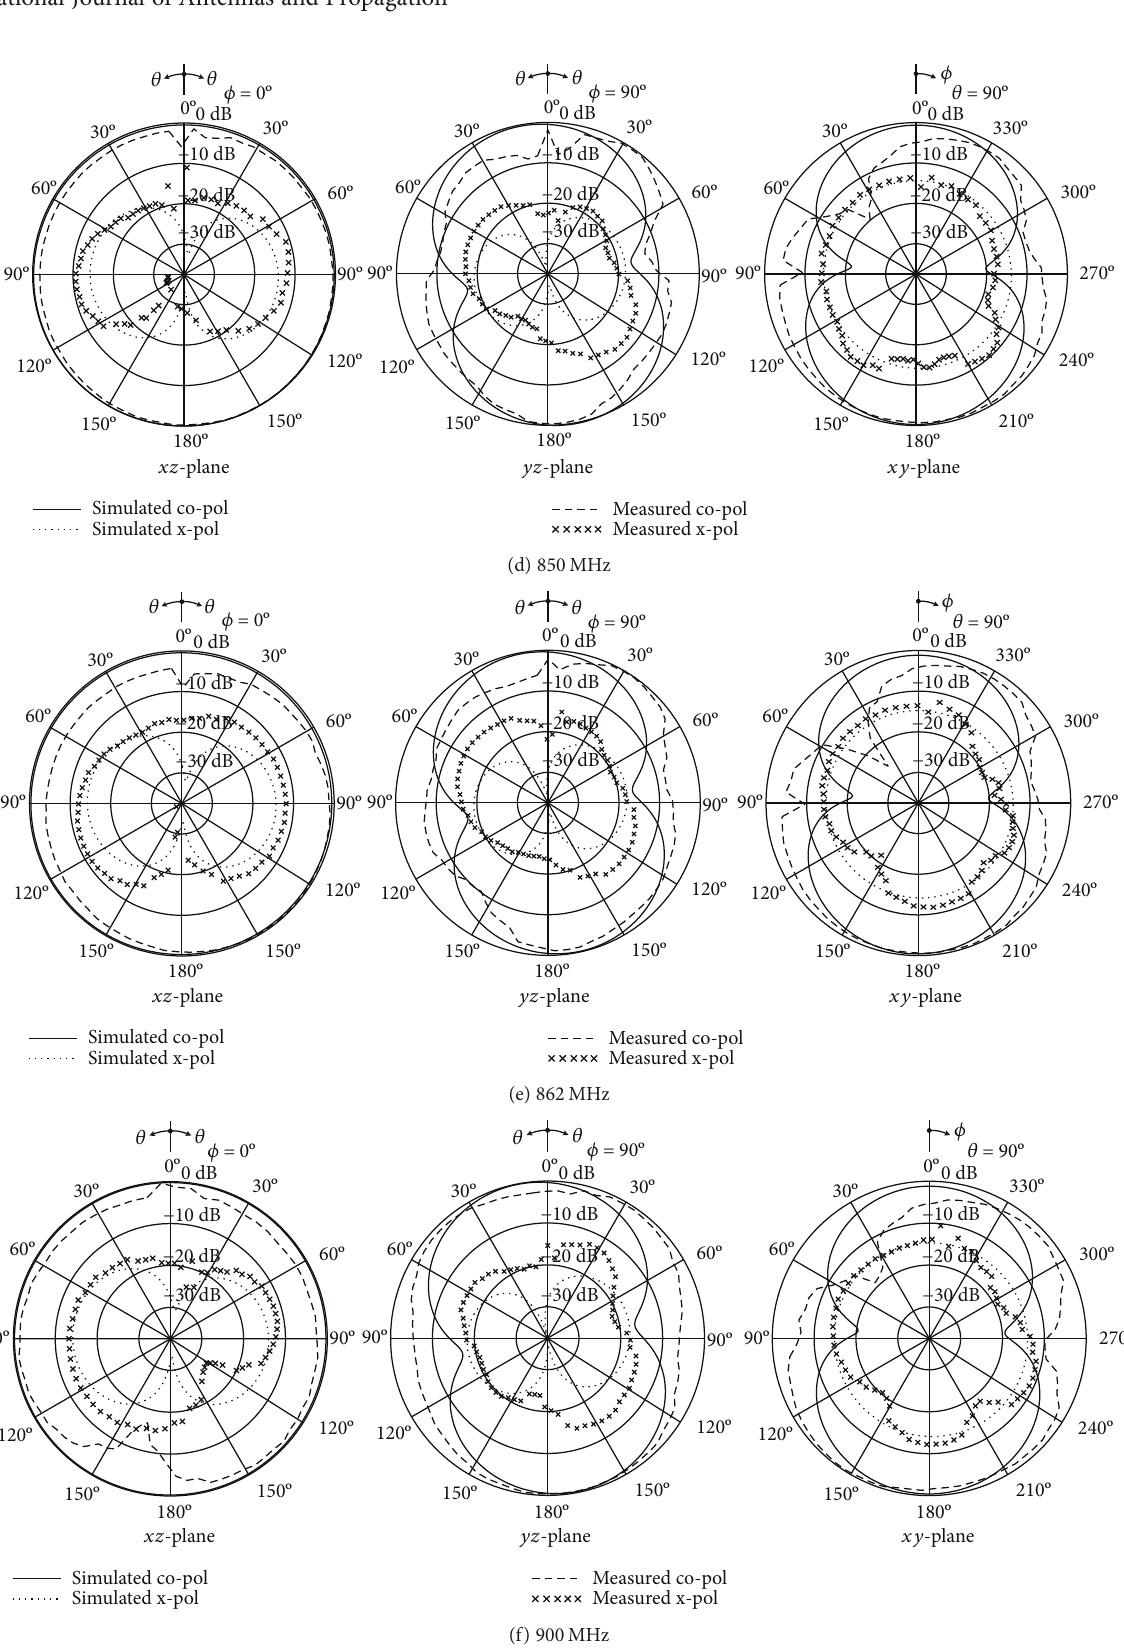
Figure 13: The simulated and measured radiation patterns of the MD-loaded MLA: (a) 470 MHz, (b) 666 MHz, (c) 766MHz, (d) 850 MHz, (e) 862MHz, and (f) 900